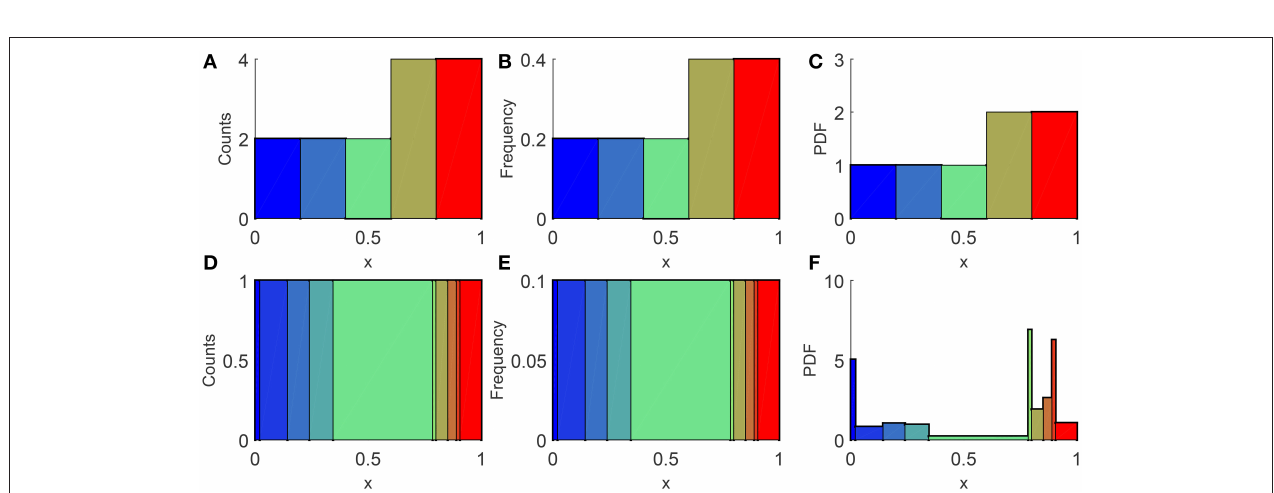
FIGURE 4 | Log-log plot of d KS against N for different deciles going from the 10th percentile (blue) to the 90th (red), obtained from 10 6 simulations.